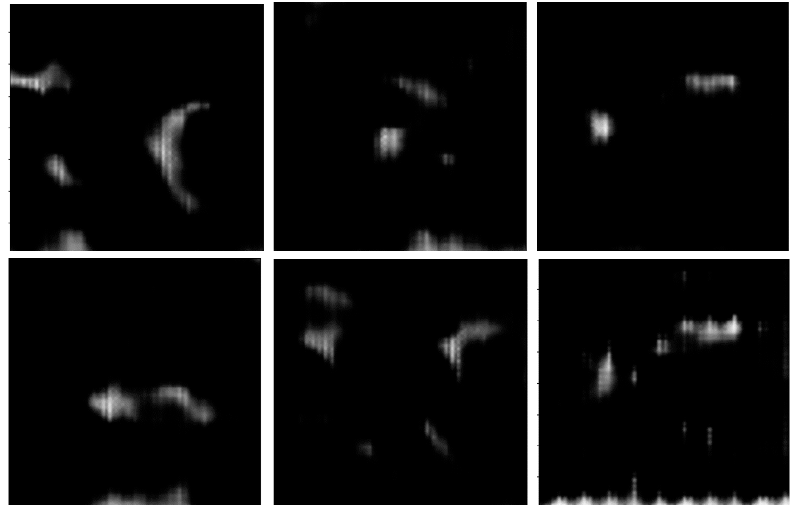
Figure 9. Samples of synthetically generated optical flow data.